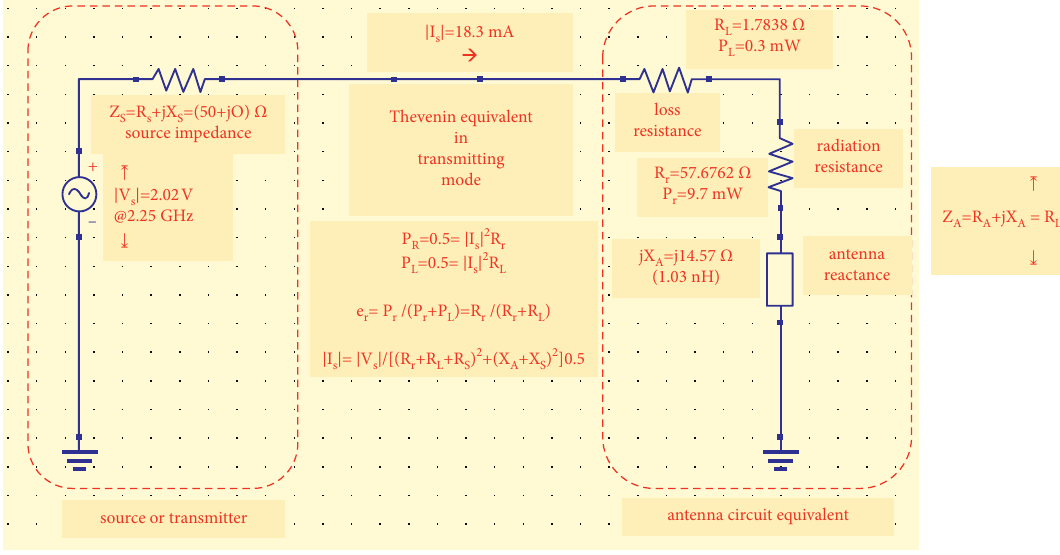
Figure 9: Antenna circuit analysis at 2.25GHz. Table 5: Resonance and design frequencies